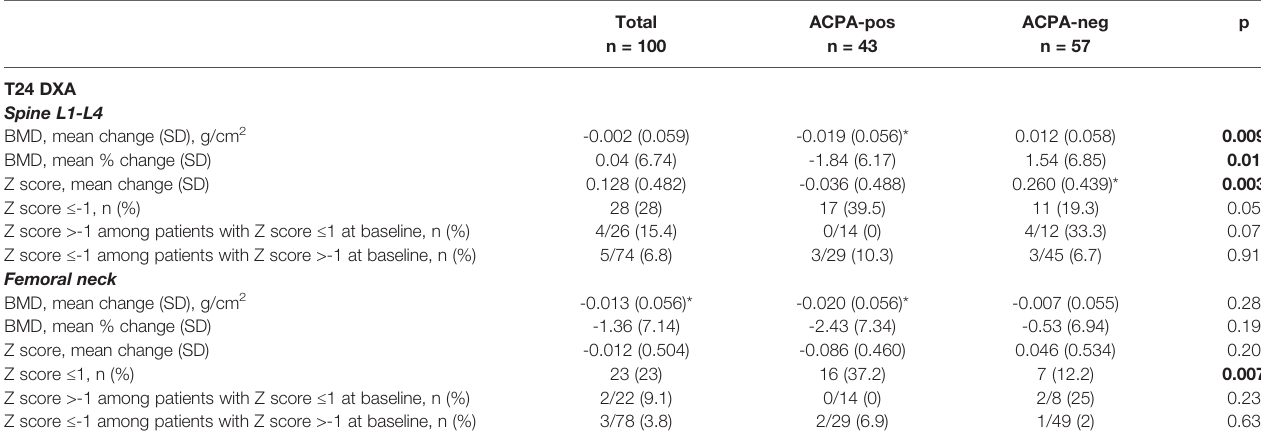
TABLE 2 | Changes in BMD from baseline.